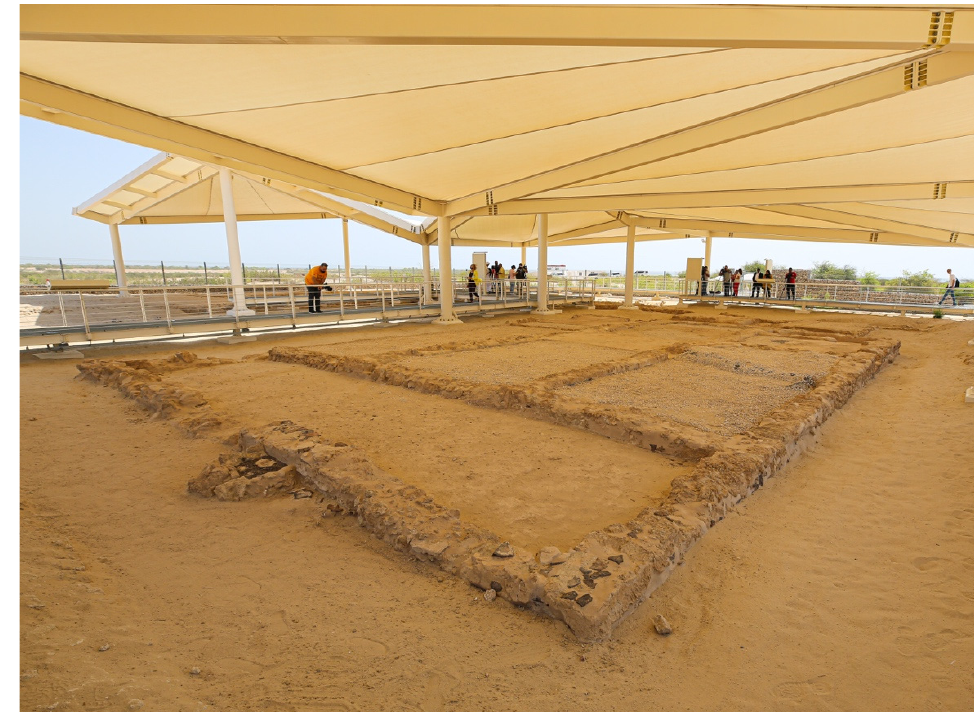
Figure 4. Current perspective on the site, incl. shelter and walkway.